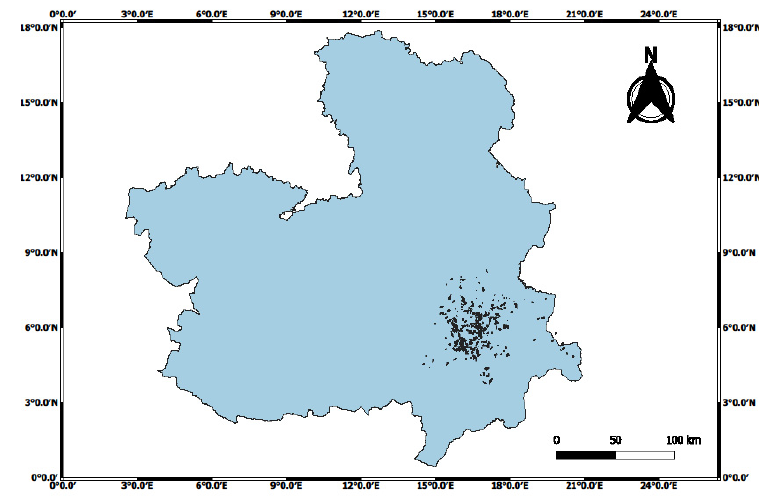
Figure 1. Locations of the reference data.